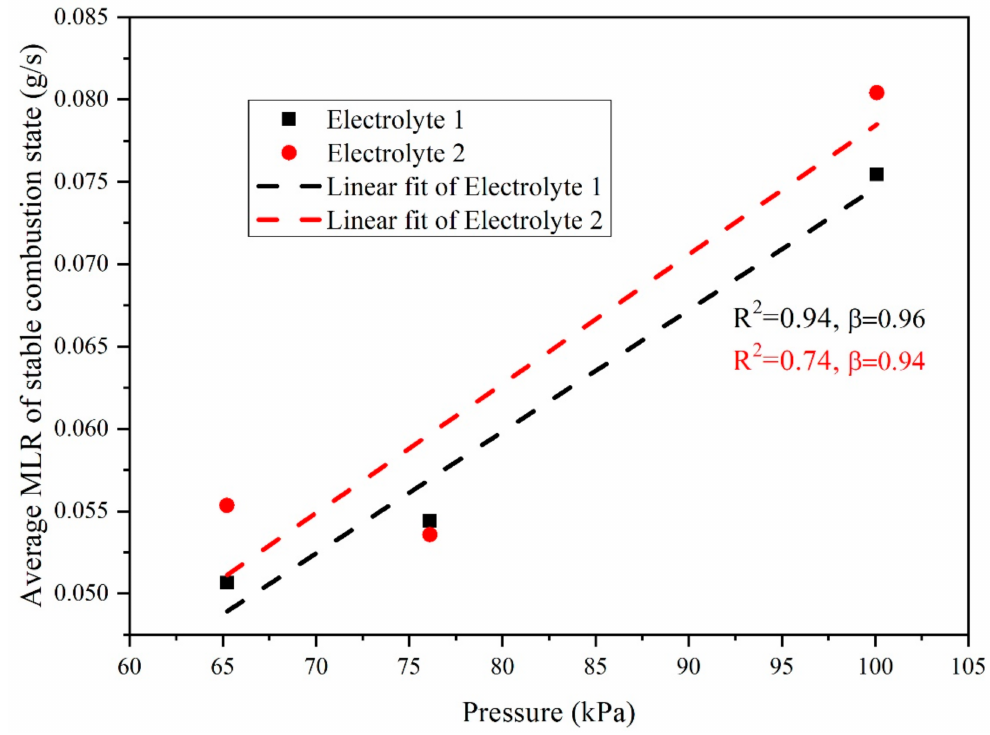
Figure 5. Average MLR and pressure fitting